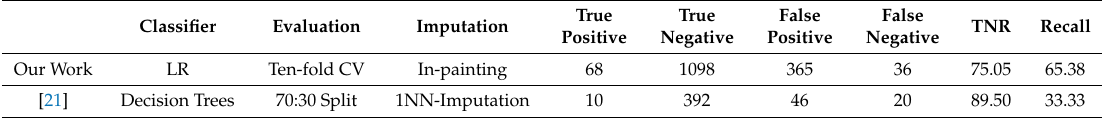
Table 2. Comparison of the results to a similar work